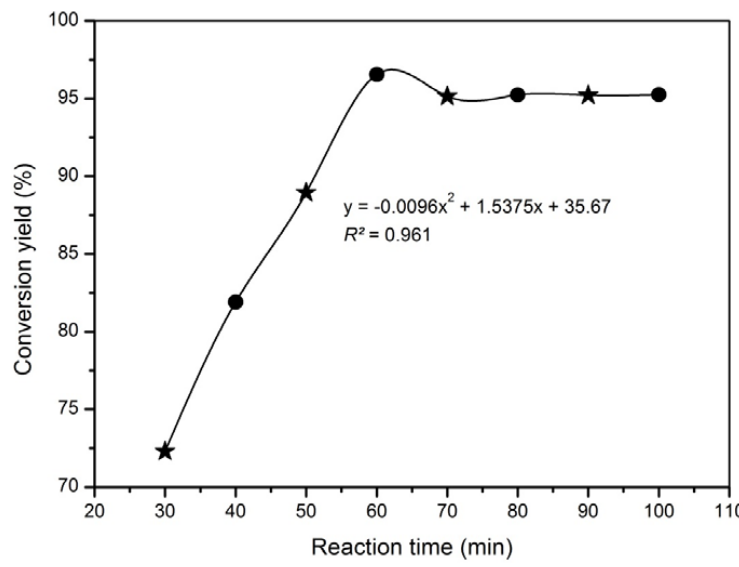
Figure 8. Effect of reaction time on conversion yield at 1 wt % KOH, 6:1 methanol–oil ratio, continuous 750 rpm stirring speed at 60 °C reaction temperature.